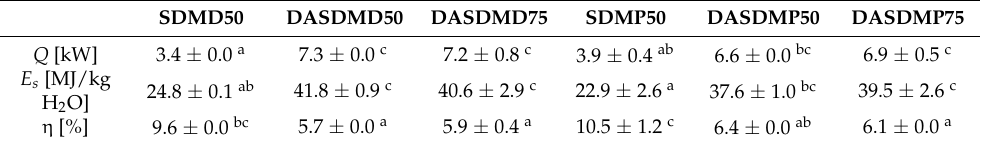
Table 4. Rate of energy consumption ( Q ), specific energy consumption ( E s ) and energy efficiency ( η ) of conventional spray drying (SD) and dehumidified-air-assisted spray drying (DASD) of buckwheat honey solutions containing 50 and 75% honey solids and maltodextrin (MD) or milk powder (MP) as